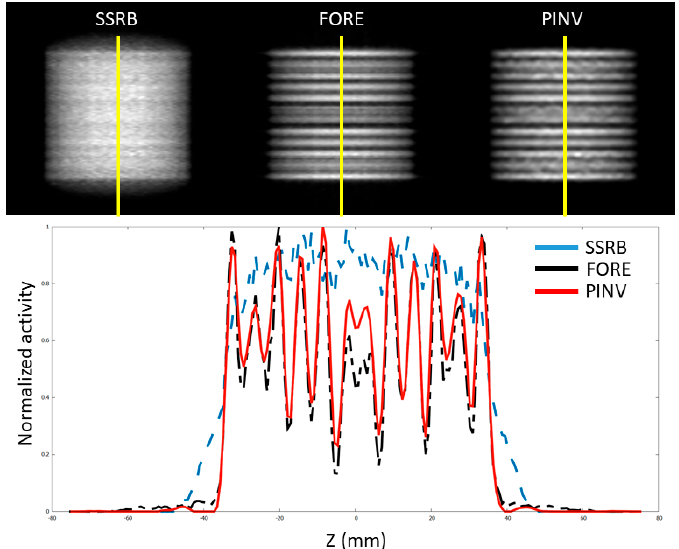
Figure 6. Axial profile of a simulated thin-slice (XX mm slices thickness) Defrise phantom for the SuperArgus scanner reconstructed from the three rebinning methods ( top ) and a profile along the axis of the scanner ( bottom ), that is, along the yellow line in the top panel. PINVz rebinning employed 20 iterations.